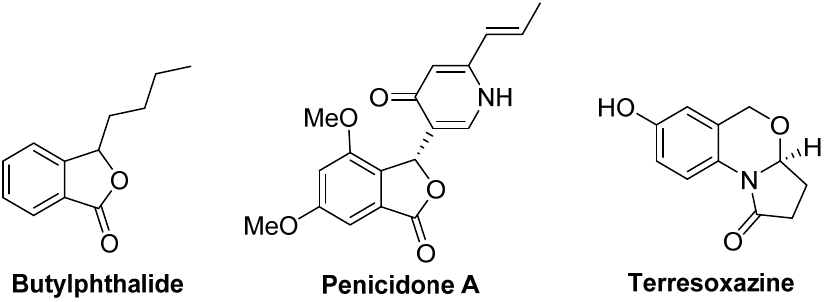
Figure 1. Some representative polyheterocyclic molecules.